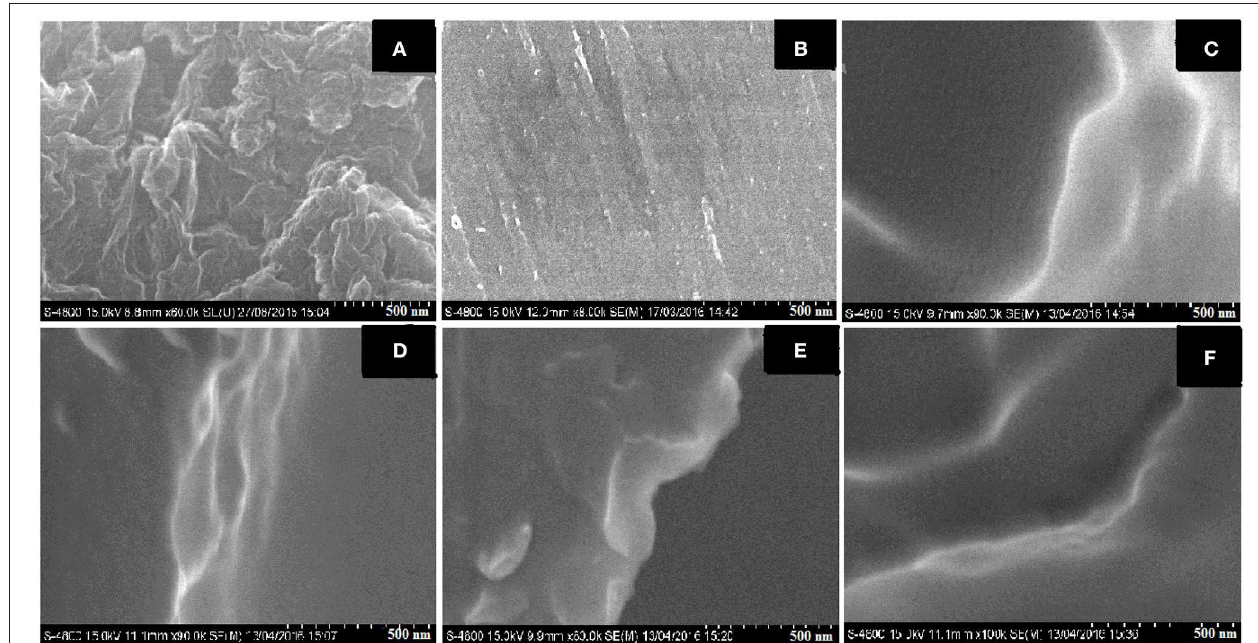
FIGURE 4 | FE-SEM images of (A) GO, (B) virgin epoxy, (C) 0.2 wt% GO/E, (D) 0.3 wt% GO/E, (E) 0.4 wt% GO/E, and (F) 0.5 wt% GO/E